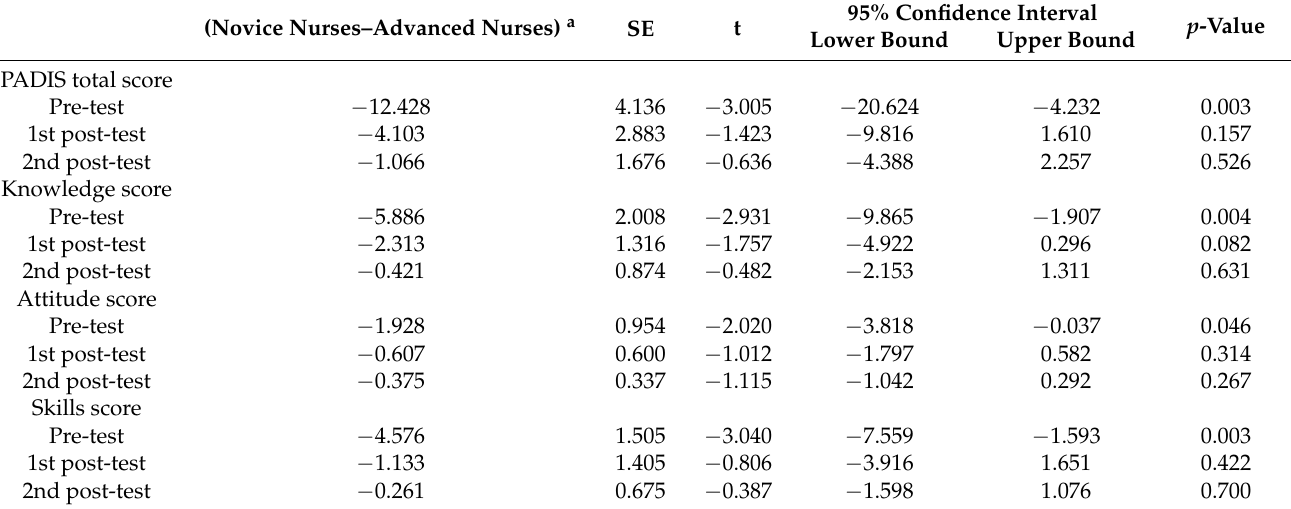
Table 4. Differences between novice and advanced nurses by Repeated measure